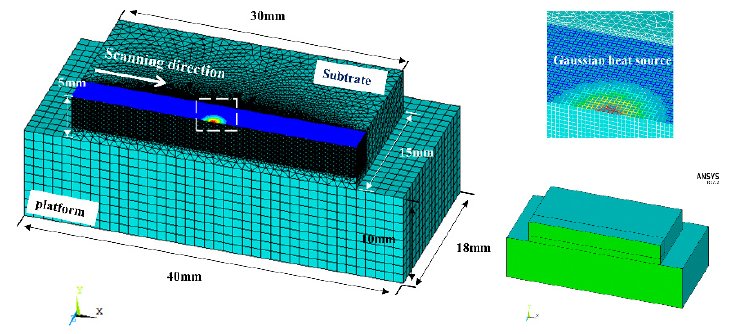
Figure 2. Finite element mesh.